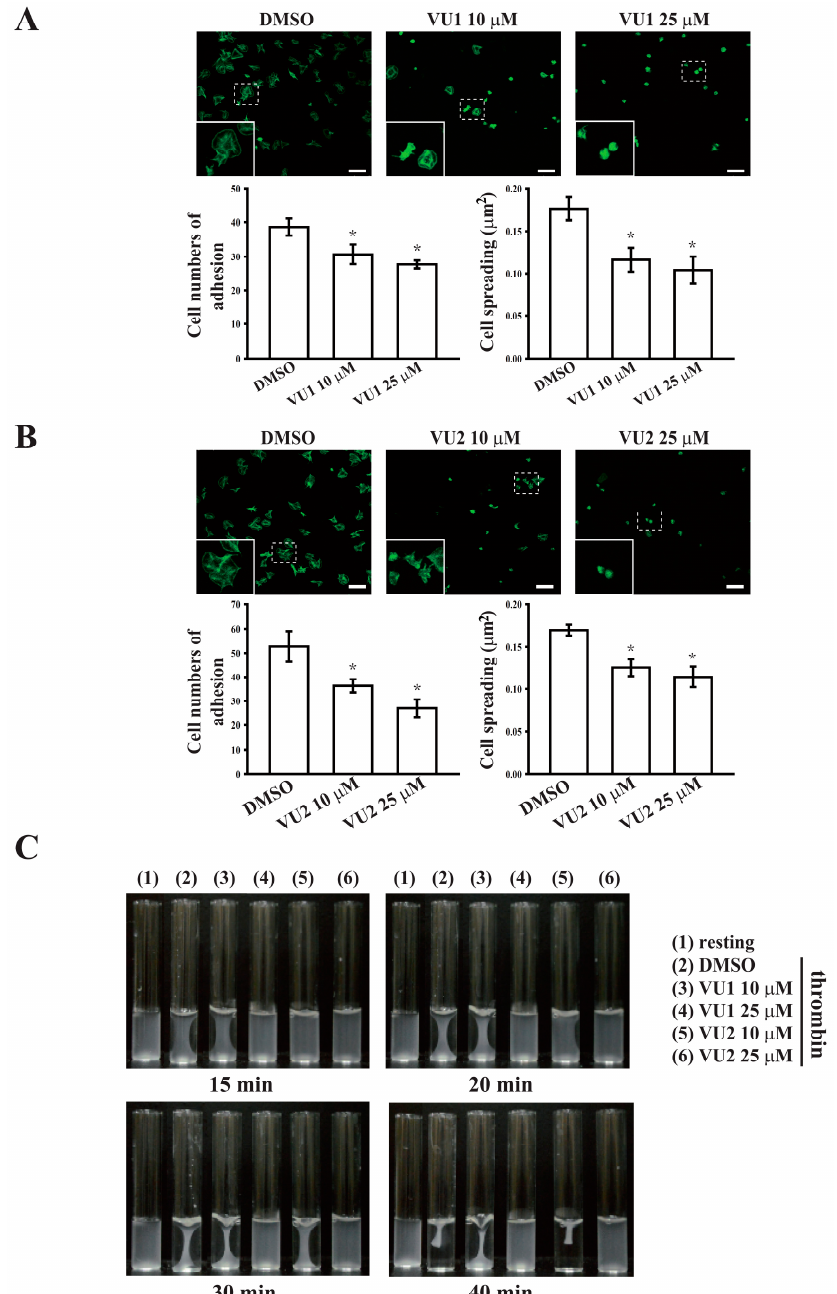
Figure 5. Regulatory effects of PLD on platelet adhesion, spreading, and clot retraction. ( A , B ) Washed platelets (3 × 10 7 cells/mL) were preincubated with DMSO, VU1 (10 and 25 µ M), or VU2 (10 and 25 µ M) and allowed to adhere and spread on immobilized fibrinogen for 1.5 h. After fixation, cells were stained with FITC-phalloidin, and images were obtained using a confocal microscope. Scale bar: 10 µ m. The inset indicates the high magnification image of the region marked by dashed box. ( C ) Platelet suspensions (3.6 × 10 8 cells/mL) were pretreated with DMSO, VU1 (10 and 25 µ M), or VU2 (10 and 25 µ M) for 3 min, and subsequently, clot retraction was initiated using thrombin (0.01 U/mL) in the presence of fibrinogen and CaCl 2 . Clot retraction was allowed to proceed at 37 ◦ C in an aggregometer tube and photographed at the indicated times. Data ( A , B ) are presented as means ± SEM ( n = 3). * p < 0.05, compared with the DMSO (solvent control) group. Profiles ( C ) are representative examples of three similar experiments.